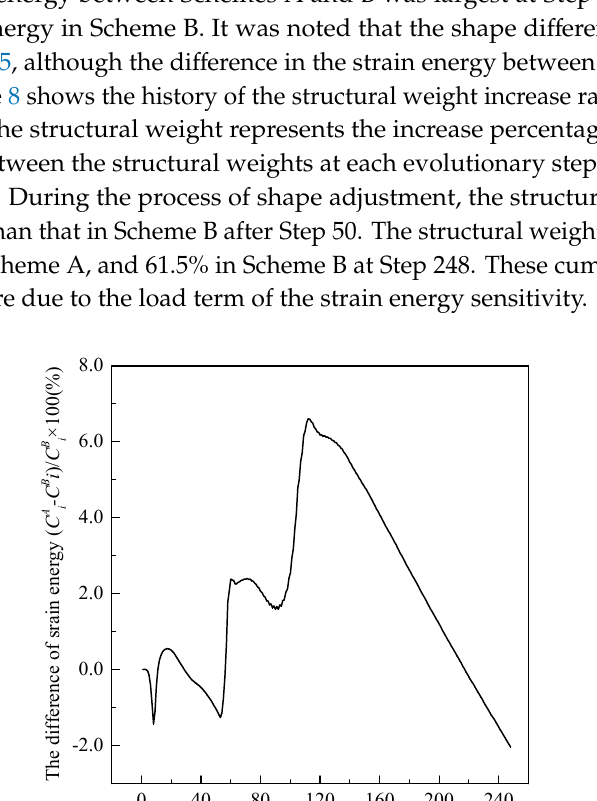
Figure 7. The di ff erence of the strain energy between Schemes A and B at the same Figure 7. The difference of the strain energy between Scheme A and B at the same step.